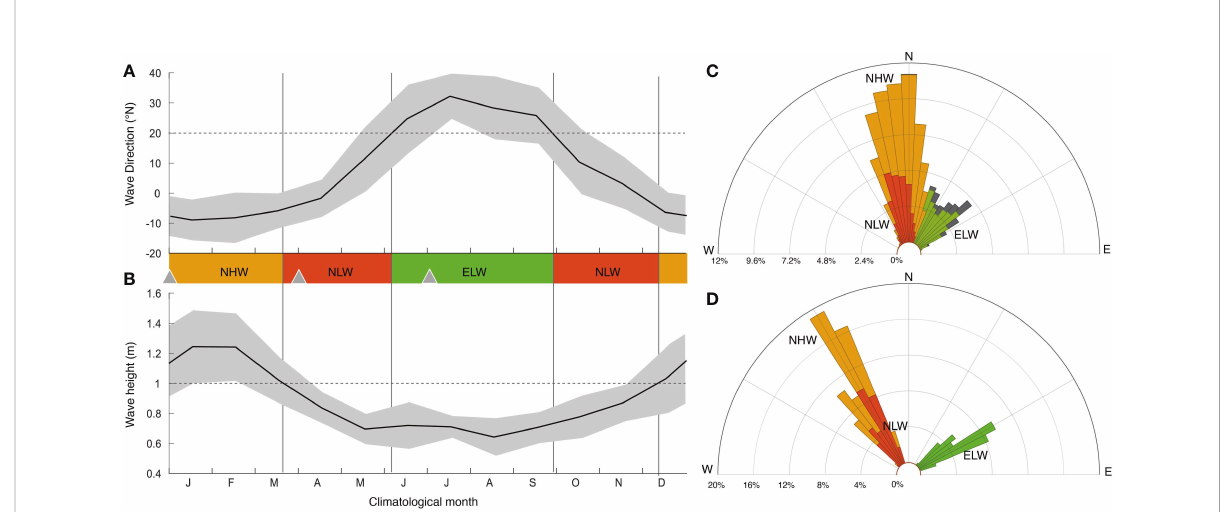
FIGURE 3 Characteristics of the surface wave forcing: Observed seasonal climatology of the signi fi cant wave height (A) and the wave direction (B) at the LTER1 fore reef site, constructed from the monthly averages of the data obtained in 20 minutes intervals from 2004 through 2018 (Washburn, 2019). (C) Windrose histogram of the wind direction from daily averages of the same measurements between 2004 and 2018. The observations were grouped into three wind forcing regimes, i.e., a northerly high wave regime (NHW, yellow) with monthly wave heights > 1 m and waves coming from northerly directions (-20 to 20 °), a northerly low wave regime (NLW, red), which corresponds to waves from the same direction, but with monthly wave heights < 1 m, and a northeasterly low wave regime (ELW, green) with waves coming from northeasterly direction (20 to 60 °). (D) Windrose histogram of the hourly forcing used to run the model for the three wave forcing regimes. Shown in (B) as triangles are the starting days for the time-slice simulations for each of the three wind regimes. See text for